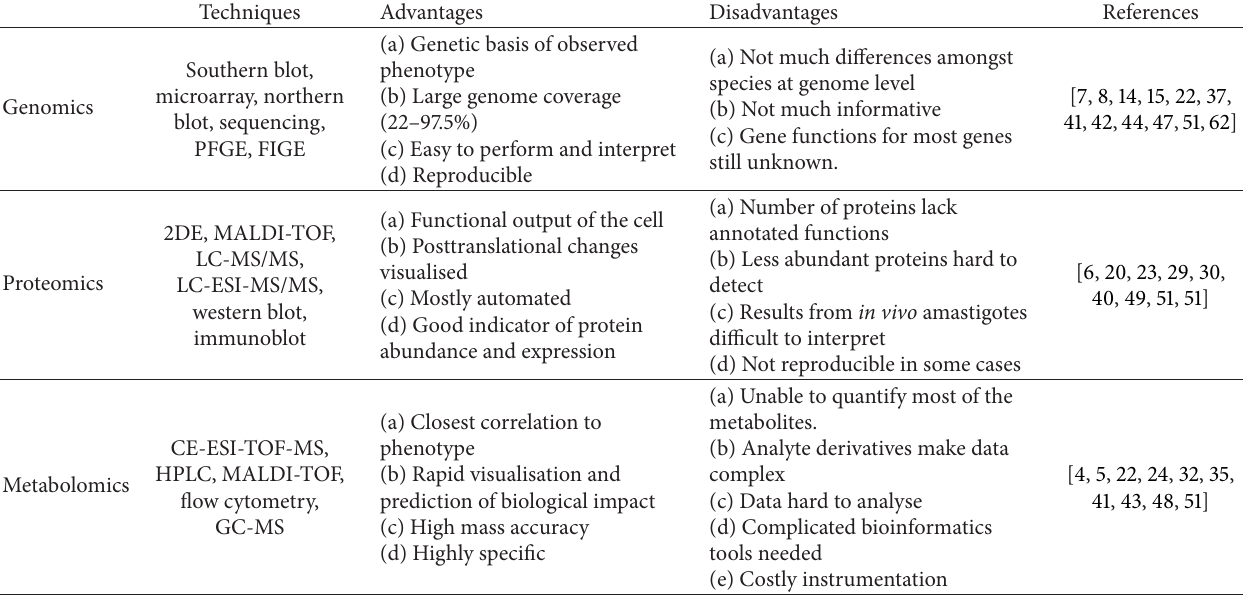
Table 2: The advantages and disadvantages of strategies used to study drug